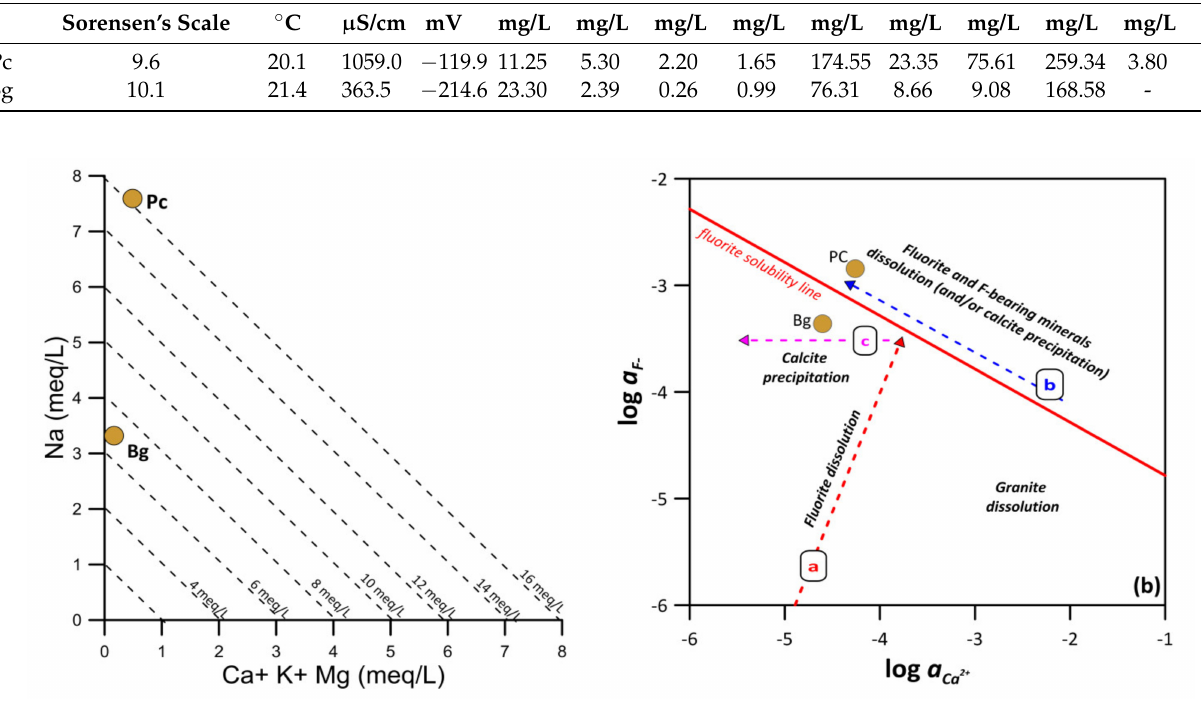
Figure 3. ( a ) Correlation diagram of Na vs. Ca + K + Mg for the studied samples, also reporting selected iso-salinity lines and ( b ) plot of activity of Ca vs. activity of F in which three geochemical pathways are reported, as well as the fluorite solubility line